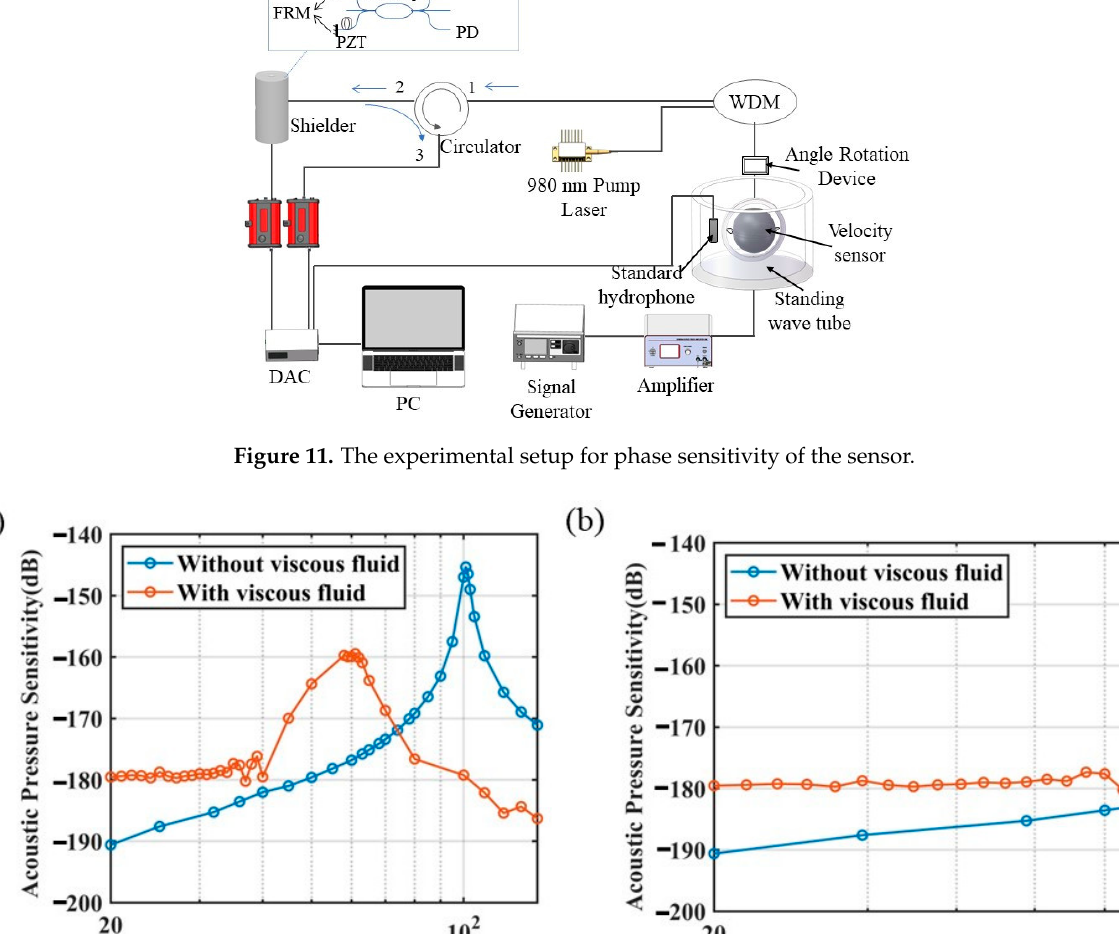
Figure 11. The experimental setup for phase sensitivity of the sensor.